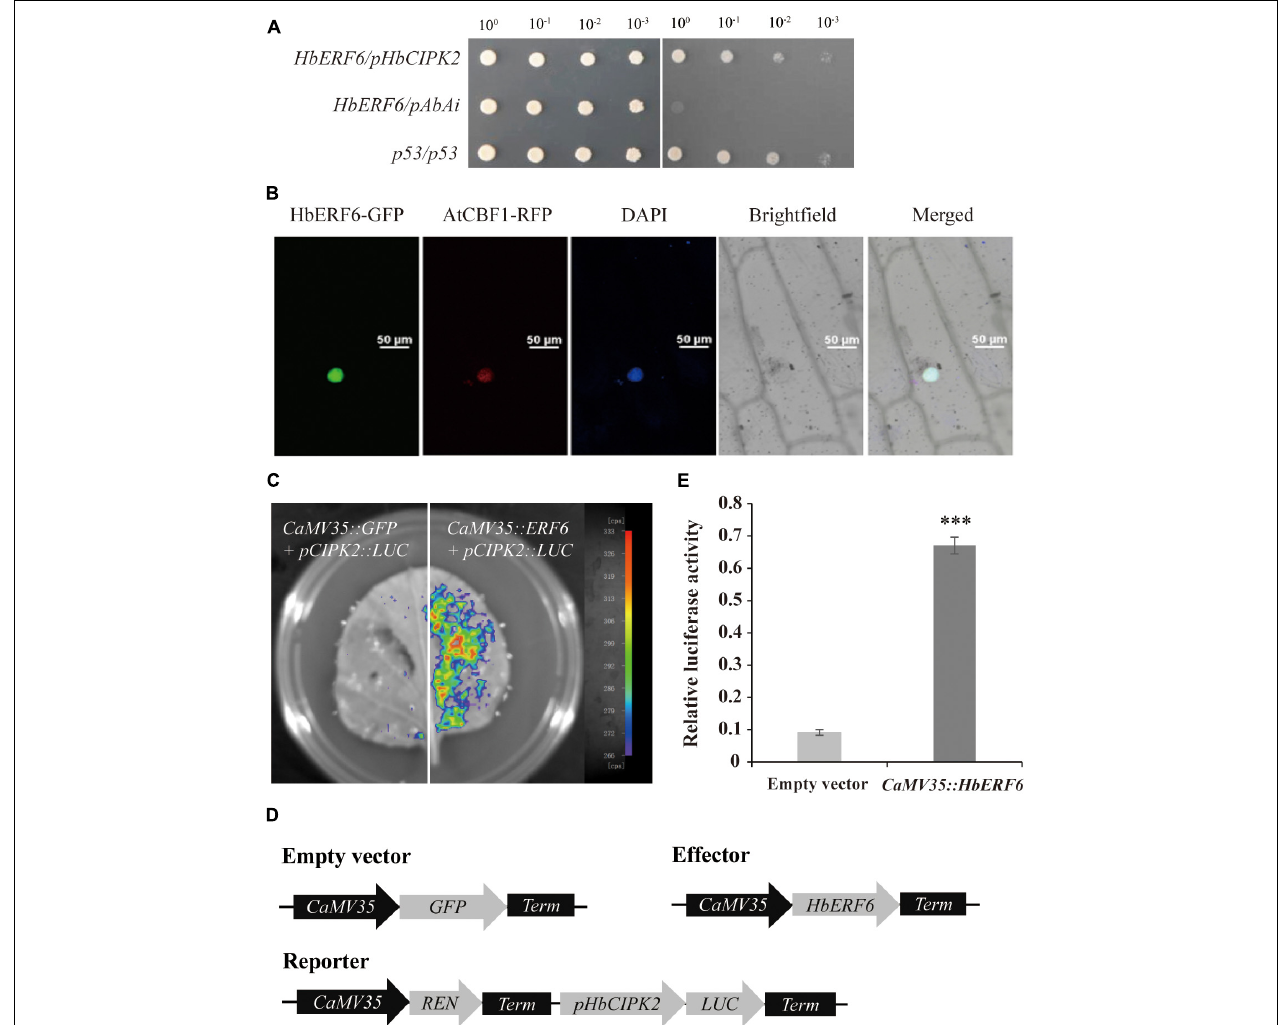
FIGURE 2 | HbERF6 can interact with the HbCIPK2 promoter in yeast and activate HbCIPK2 in N. benthamiana leaves. (A) Interaction of the HbERF6 and HbCIPK2 promoter was determined based on the ability of transformed yeast to grow on SD/-leu and SD/-Leu/AbA (300 mg/L). (B) Nuclear localization of the HbERF6-GFP fusion protein in onion cells. Bar = 50 µ m. (C) A luciferase imaging assay indicated that HbERF6 can activate the expression of HbCIPK2 . (D) Diagrams of relevant vectors used in the dual luciferase assay. HbERF6 was cloned into the pGreenII 62-SK vector as an effector, the promoter of HbCIPK2 was inserted into the pGreenII 0800-LUC vector as a reporter, and each of REN, Renilla luciferase, was used as an internal control. (E) The relative LUC activities indicated that HbERF6 can enhance the promoter activity of HbCIPK2 in N. benthamiana leaves. Statistical analysis was performed by one-way ANOVA; asterisks indicate significant variation ( ∗∗∗ P <